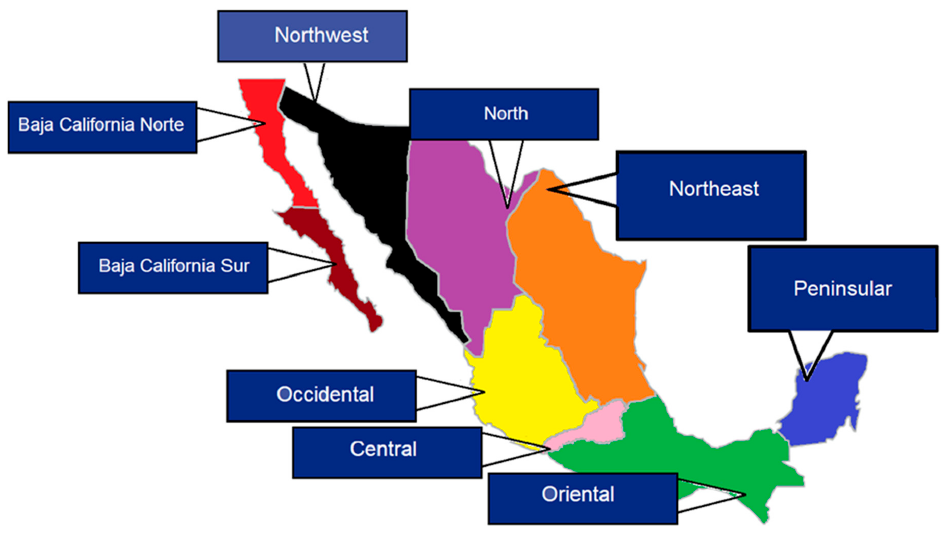
Figure 4. Electric National System of Mexico.